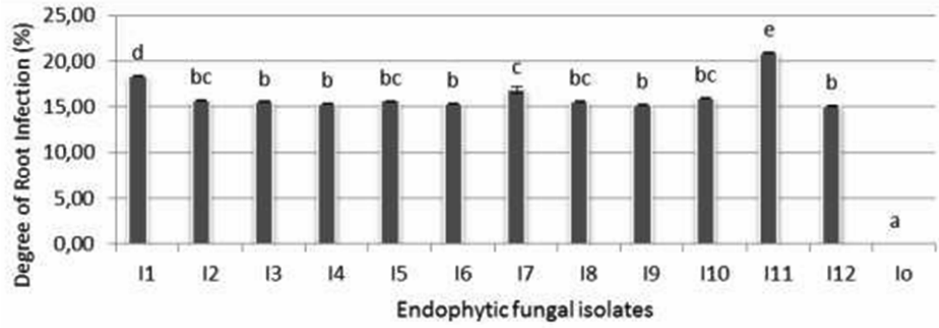
Fig. 5. The colonization of endophytic fungi isolates on the root of rice seedlings Table